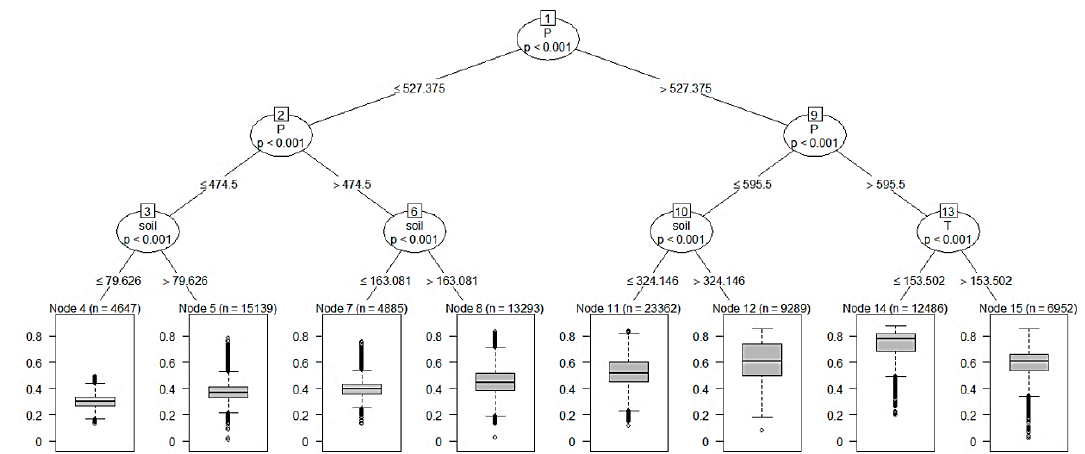
Figure 8. NDVI factor interactions derived from the classification and regression tree (CART) model. Note: In the above figure, the dataset is represented as a tree plot (upper part), reporting the importance of the interactions between factors with a downwards trend. The factors are as follows: p is the total precipitation during the growing season, soil is the average soil moisture during the growing season, and T is the average temperature during the growing season. Additionally, the boxplot at the terminal nodes level (lower part) shows how their interaction affects the estimated NDVI.